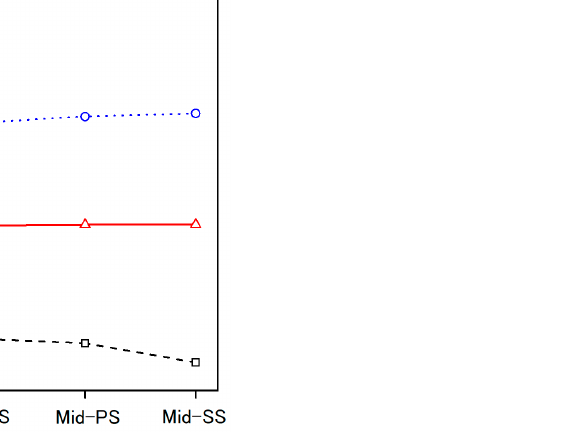
Figure 18. Area-averaged heat-transfer coefficient on the S 2 vane surface under different damaged- blade conditions.